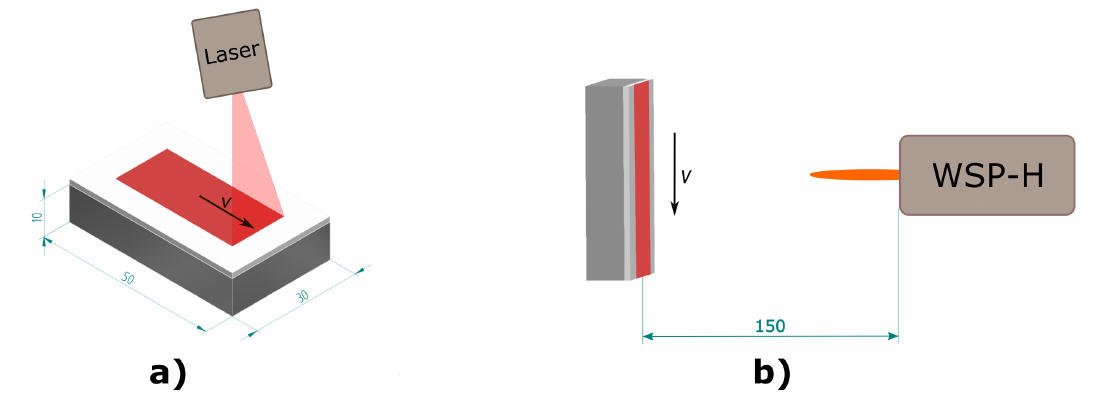
Figure 1. Schematic illustration of samples surface heat-treatment by laser ( a ) and WSP-H plasma torch ( b